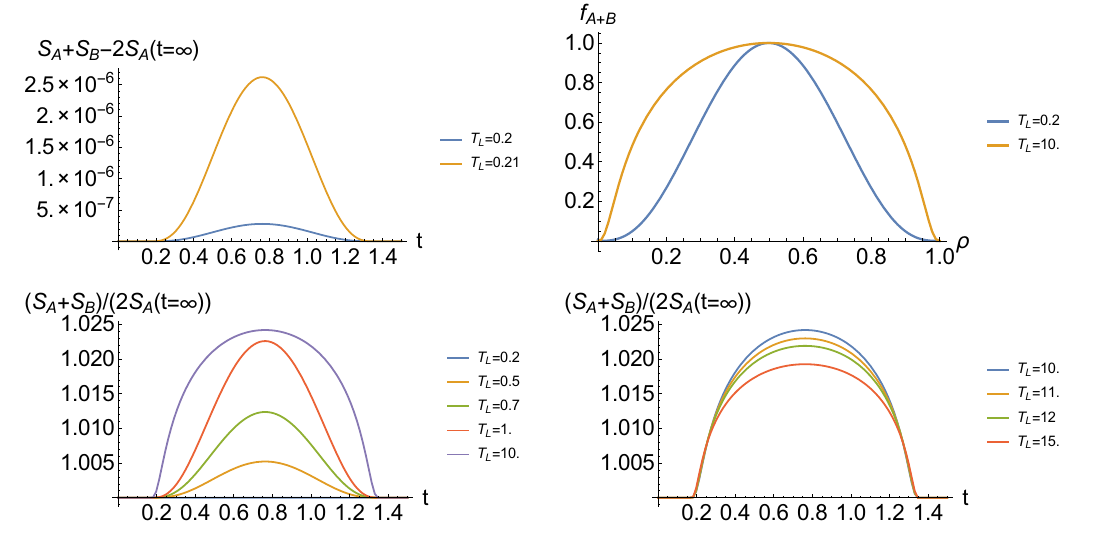
Figure 14 . Top left : sum of S A and S B for two di(cid:11)erent, yet close, values of T L , shifted by the asymptotic ( t = 1 ) value of that sum. The blue plot is the case studied in section 3, as previously the deviation from constancy is of order 10 (cid:0) 7 while the sum is of order 10 (cid:0) 1 . The yellow plot shows a similar quantity for temperature T L = 0 : 21, just slightly higher. The deviation is now order of magnitude bigger. Top right : normalised deviation f A + B for di(cid:11)erent temperatures T L . The blue curve has been already shown in (cid:12)gure 9 to follow the universal behaviour [4 (cid:26) (1 (cid:0) (cid:26) )] 3 . For much bigger temperature T L = 10, the shape of the curve changes considerably. Bottom : ratio of sum S A + S B and asymptotic value of that sum as a function of boundary time. The deviation of the sum from its asymptotic value reaches around 2 : 5%, but seems to be bounded even when one increases the temperature | compare left and right (cid:12)gures which are in the same scale. The bigger the temperature di(cid:11)erence, the more the curve resembles a semi-circle. All lengths in units of AdS 3 radius ( L =